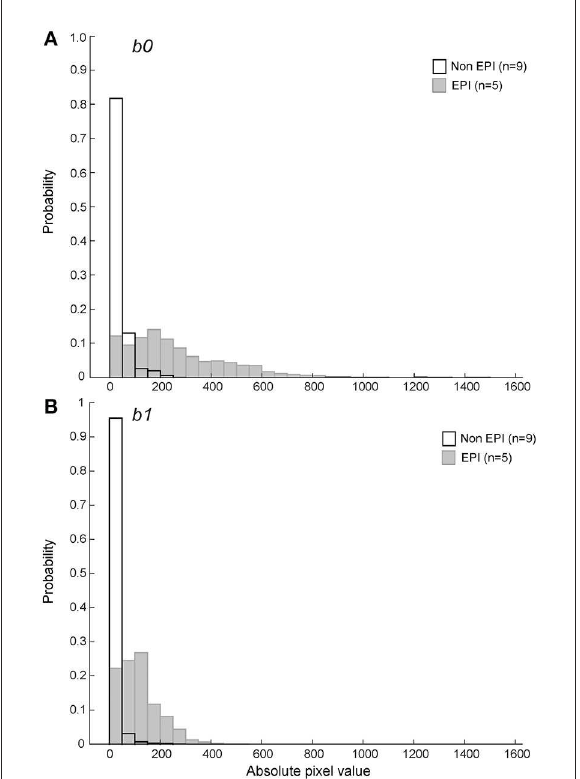
FIGURE7 Probability histograms of pixel values within the T2* hypointense ROIs for b0 (A) and b1 (B) DWI series (see text for variable definitions). Non-EPI series used b1 = 800s/mm 2 and are shown in black outline. The pixel values within ROIs defined by the